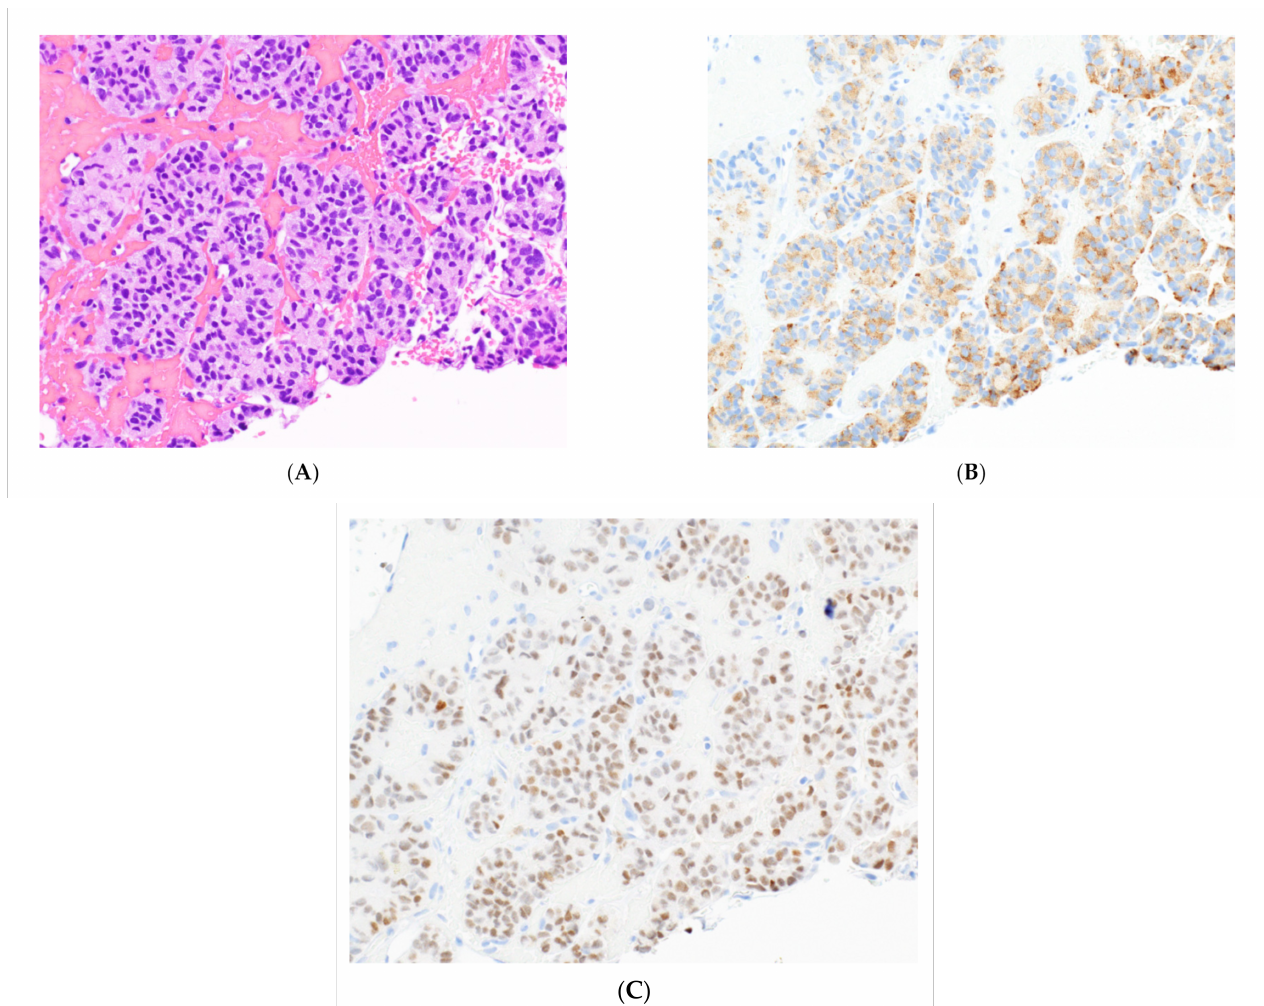
Figure 9. Thymic carcinoid tumor. ( A ) Small biopsy showing nests of cells with granular cytoplasm. H&E stain. Immunocytochemical stains of the same area show reactivity for ( B ) chromogranin, indicating neuroendocrine differentiation, and ( C ) PAX8, suggesting thymic origin. All images, 40 ×